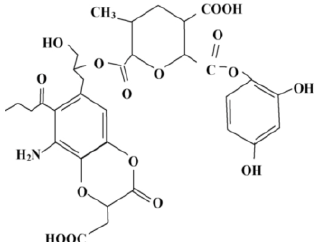
Figure 1. The chemical structure of humic